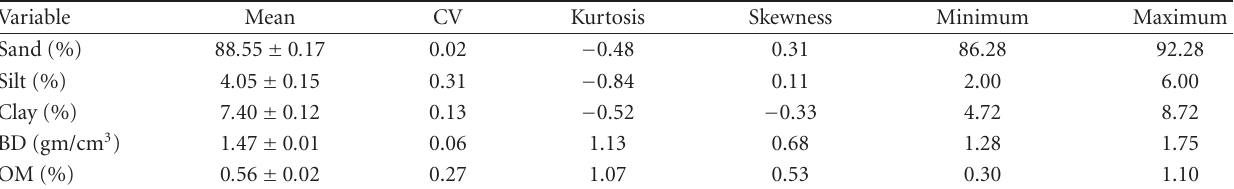
Table 1: Mean, standard error (SE), coe ffi cient of variation (CV), kurtosis, skewness, minimum and maximum of soil physical and chemical properties at 0–20 cm depth.